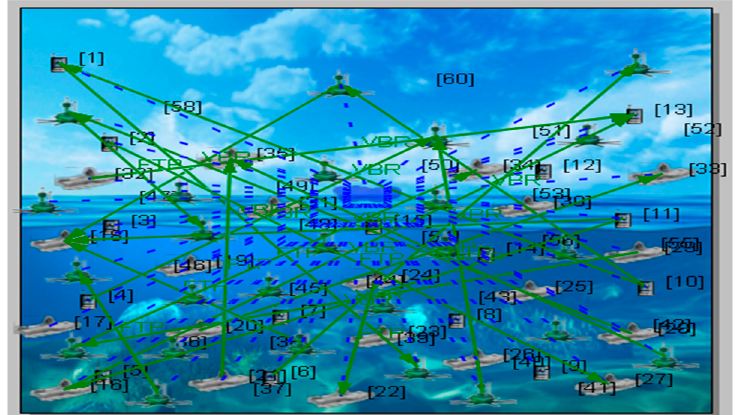
Figure 1. Typical underwater wireless communication structure.